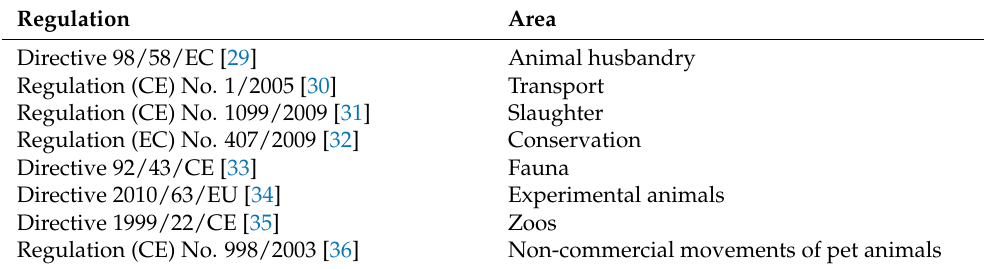
Table 1. Main European regulations on animal protection and